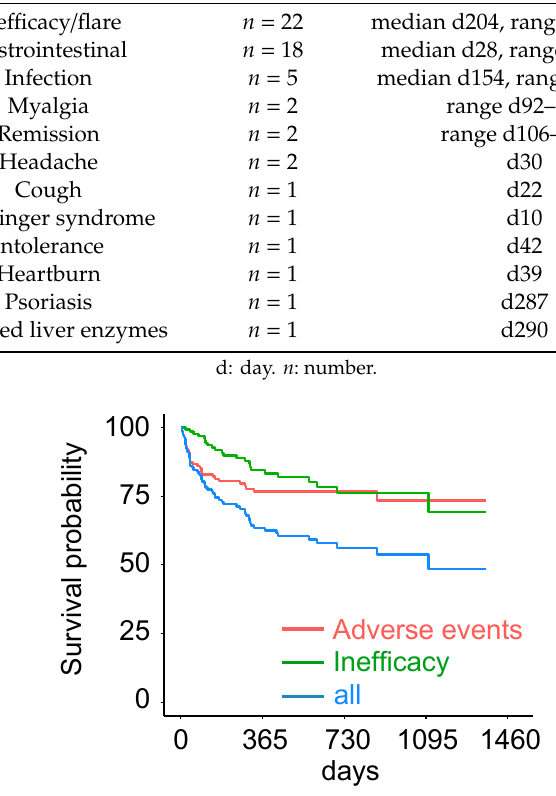
Figure 3. Time to discontinuation of tofacitinib was analyzed for all patients ( n = 57 out of 144 total patients, blue line). Patients stopping for ineffectiveness ( n = 22, green line) or adverse events ( n = 35, red line) are shown separately.